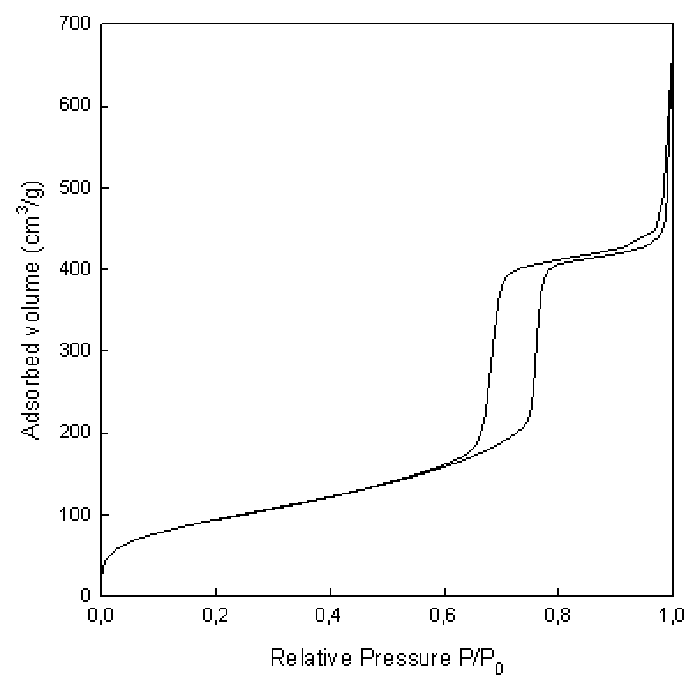
Figure 3. N 2 adsorption ‐ desorption isotherms of Cu ‐ L@SBA ‐ 15.